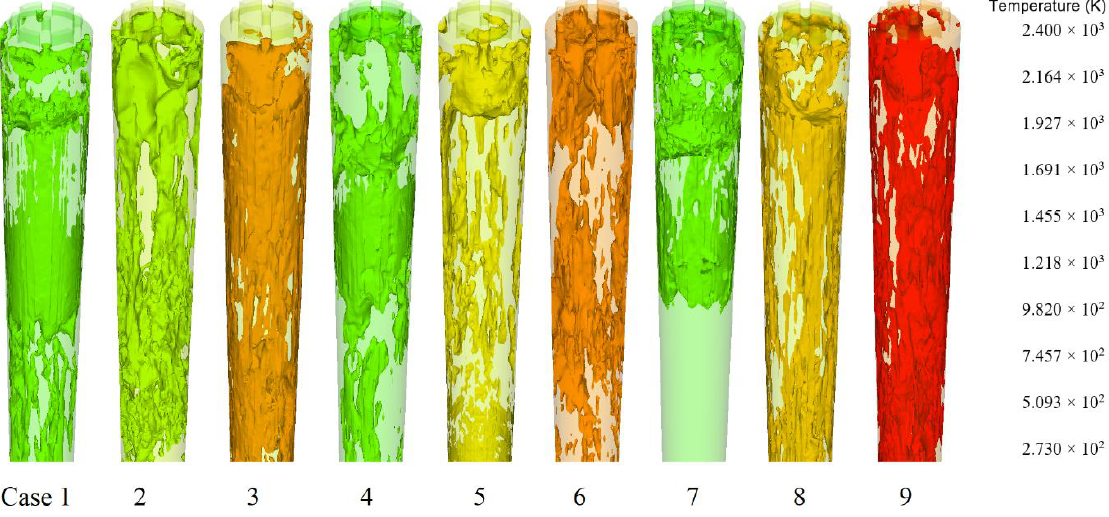
Figure 9. Carbon conversion for various cases. 3.5. Turbulent Intensity and Velocity Profile for Selected Cases The effect of the turbulence intensity and velocity are shown in Figures 10 and 11. The turbulence intensity was predicted by solving the equation of the reliable k – ε model from Equations (5) – (9). The upper part of the gasifier showed the maximum turbulent intensity range observed at 300 – 400% because the gasifier ’ s upper part was the main com- bustion reaction zone. Therefore, it was ensured that a higher mixing rate occurred in the upper part of the gasifier. Furthermore, Figure 11 shows a close view of the velocity pro- file. The velocity of the particle increased as the temperature and O/C ratio increased. The maximum velocity was observed at 10 m/s and the velocity increased as the height of the gasifier decreased.